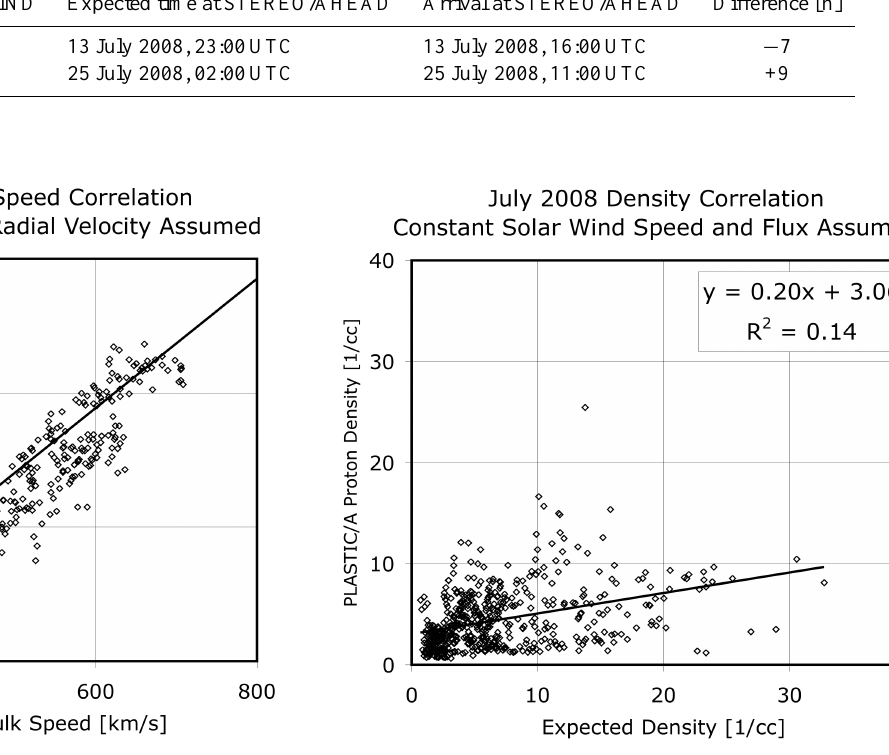
Table 1. Expected and observed times of stream interface arrival. Arrival at STEREO/BEHIND